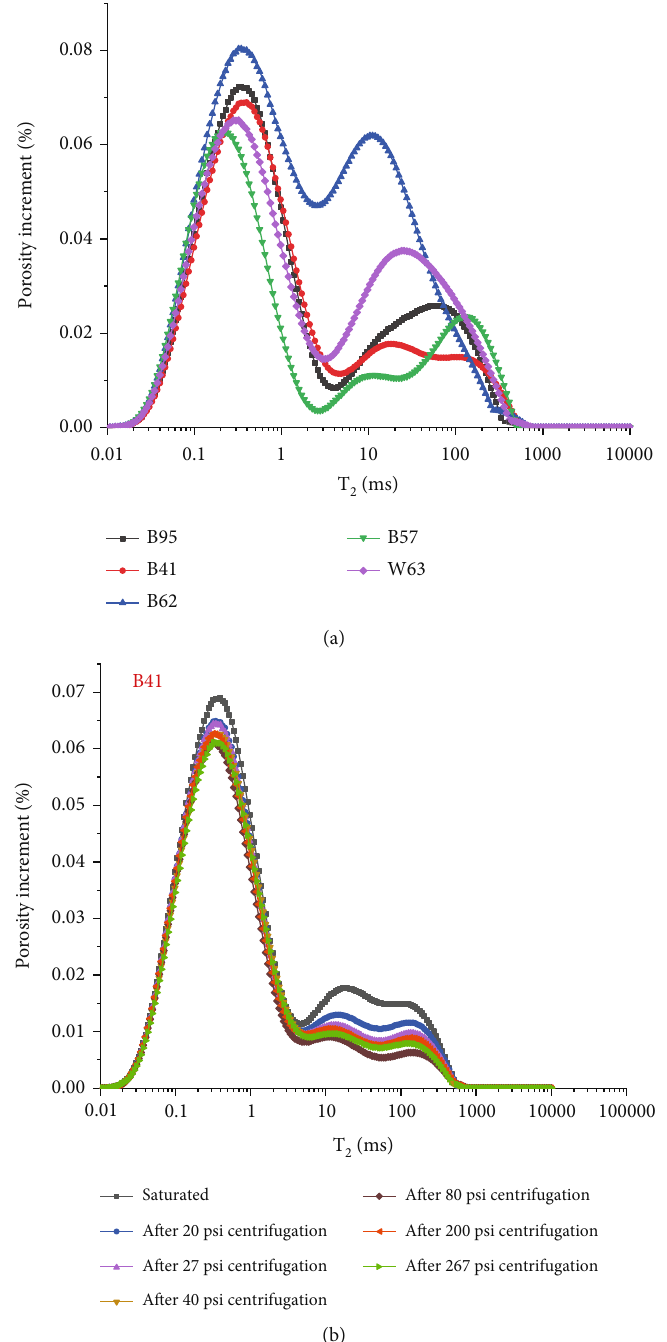
Figure 5: Characteristic of T spectrum in saturated water and centrifugal state: (a) saturated water state. (b) Typical samples in di ff erent 2 centrifugal force